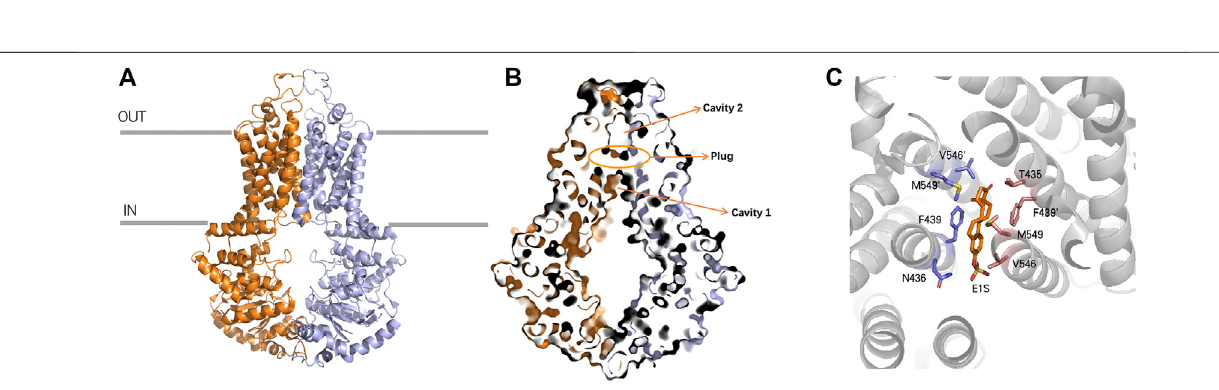
FIGURE 1 | Ribbon representation of the ABCB1 structure. (A) apo state of ABCB1, and (B) ATP-binding state of ABCB1.